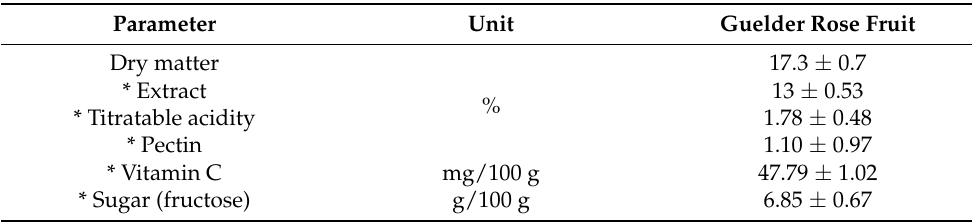
Table 1. The values of dry matter, extract, titratable acidity, pectin, vitamin C and sugar in guelder rose